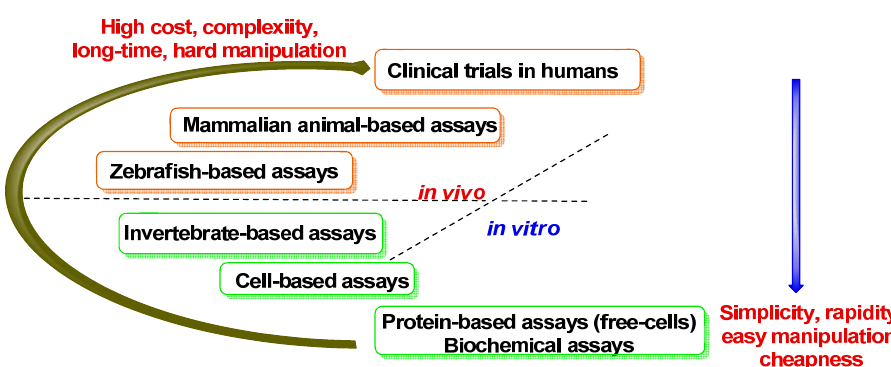
Figure 7. A diagram ofthe types of